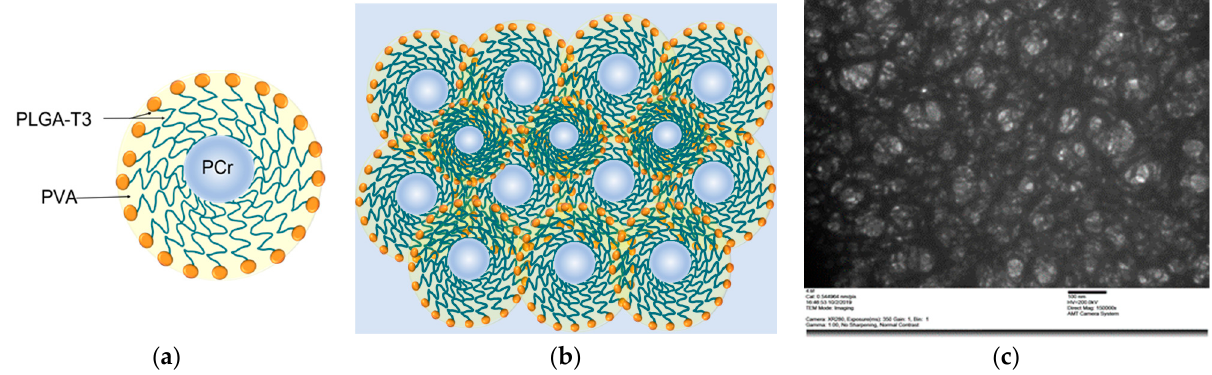
Figure 3. ( a ) Schematic draw of PLGA-T3/PCr nanoparticle. ( b ) Schematic representation of aggregate PLGA-T3/PCr nanoparticles. ( c ) TEM image of PLGA-T3/PCr NPs. TEM image with scale bar 100 nm. revealed the spherical morphology of the PLGA-T3/PCr NPs having an average size of 100–200 nm.